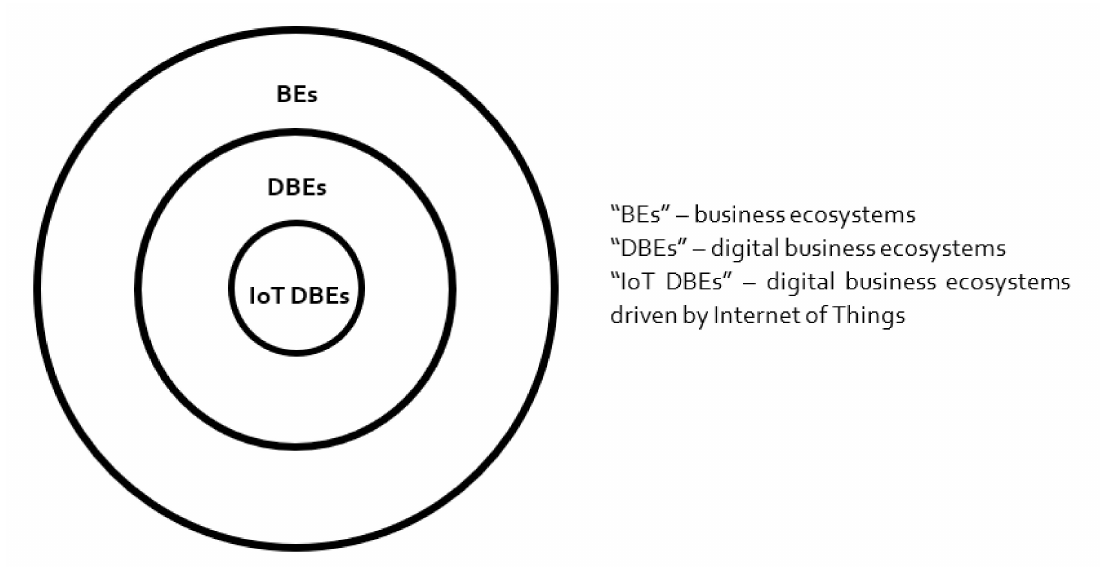
Figure 2. Proposed logic of conceptual hierarchy within the business ecosystem (BE)